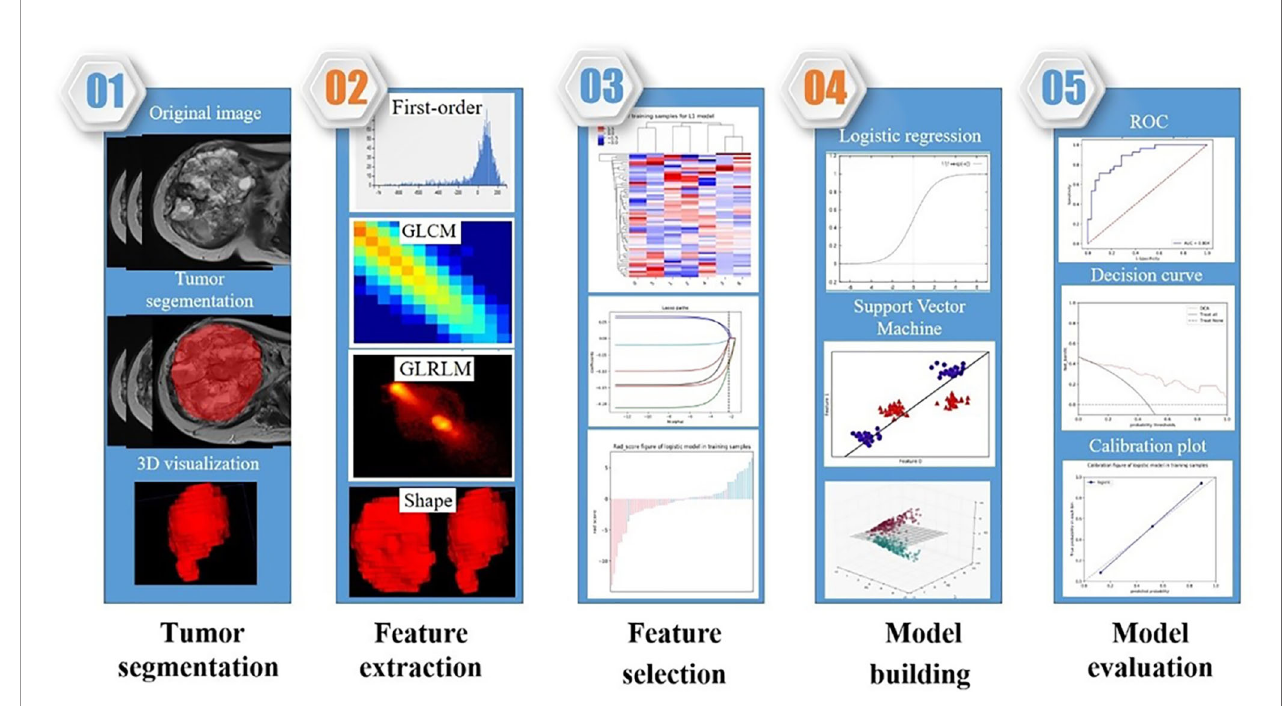
FIGURE 3 | The radiomics framework of our